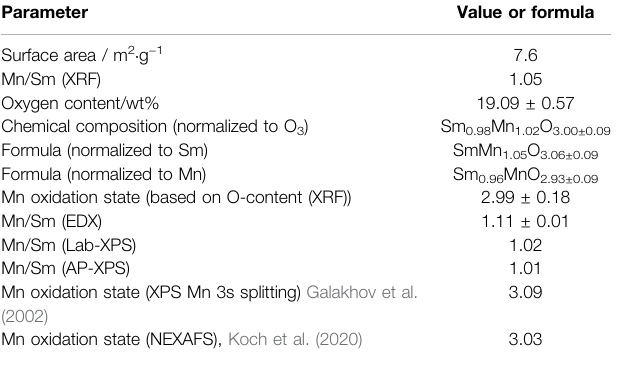
TABLE2| Surfaceareaand elementalcompositionofSm 0.96 MnO 3 obtainedfrom bulk analysis (XRF and O-content) and surface analysis (XPS and NEXAFS).